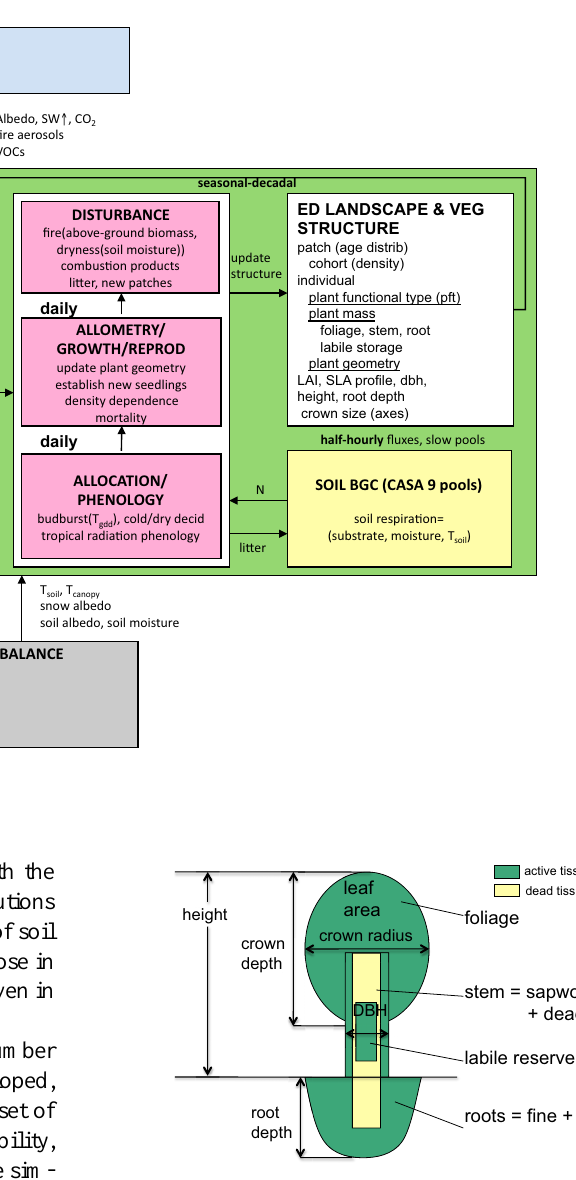
Figure 2. Ent’s individual plant biomass pools and